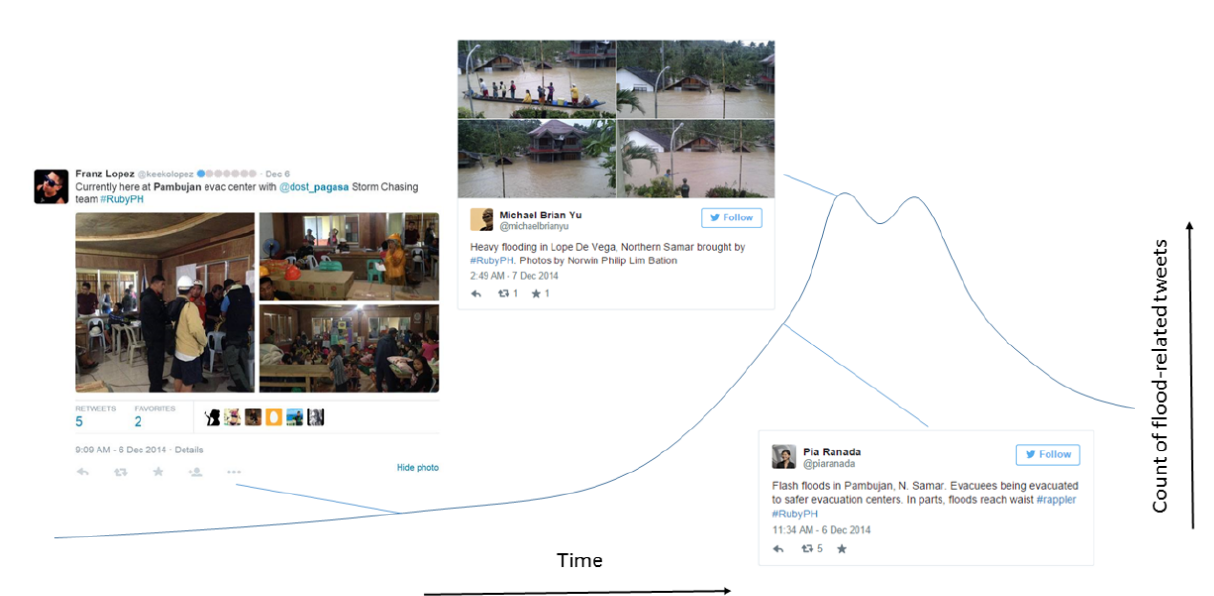
Figure 1. Schematic display of a typical Twitter count pattern leading up to a flood event (graph is illustrative; tweets are actual messages derived from flood events in the Philippines in